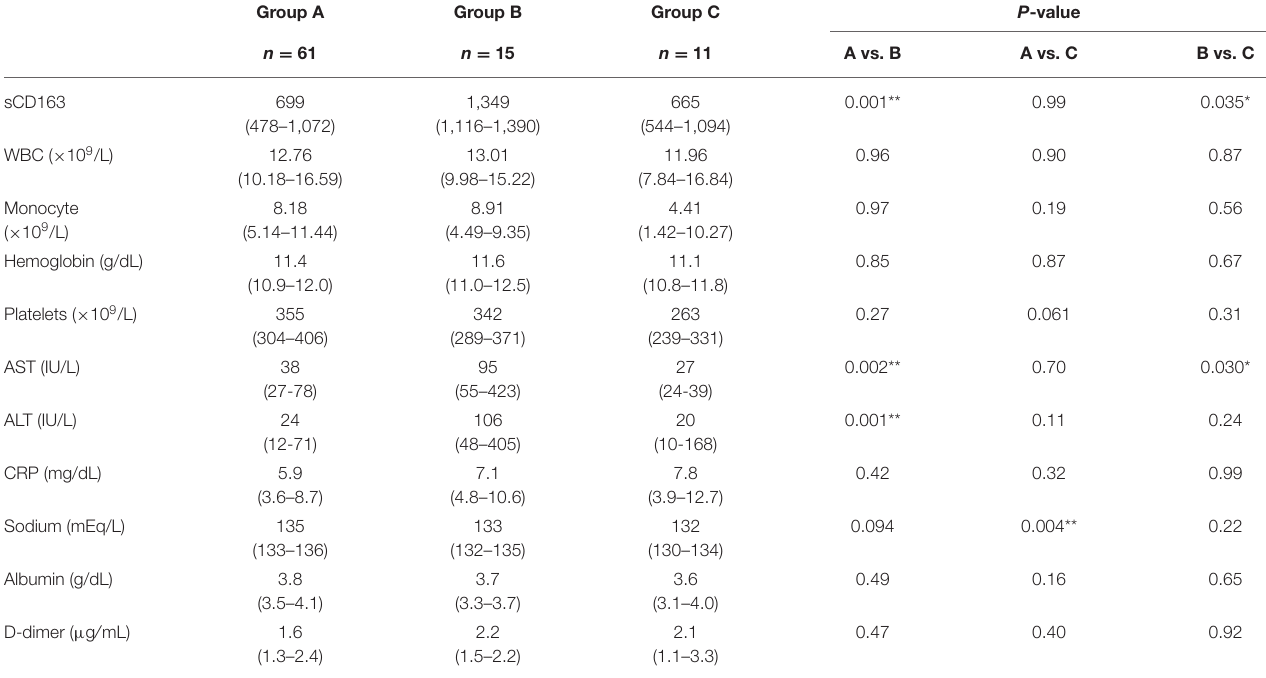
TABLE 2 | Comparison among the three